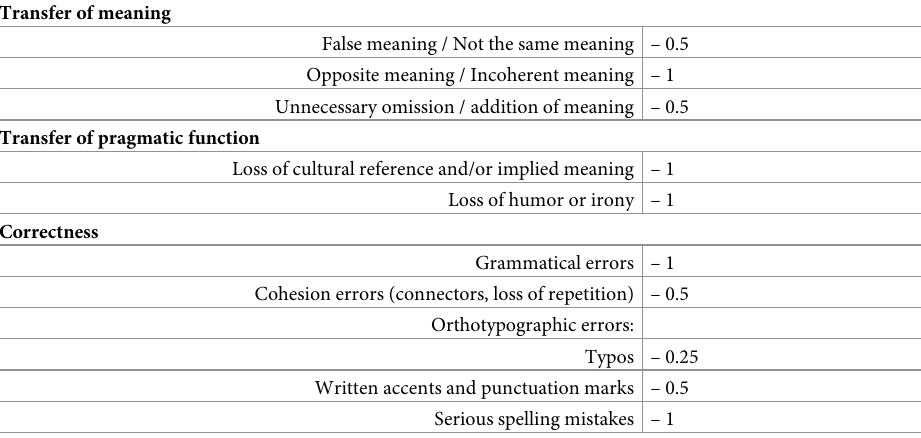
Table 3. Evaluation sheet for the assessment of target